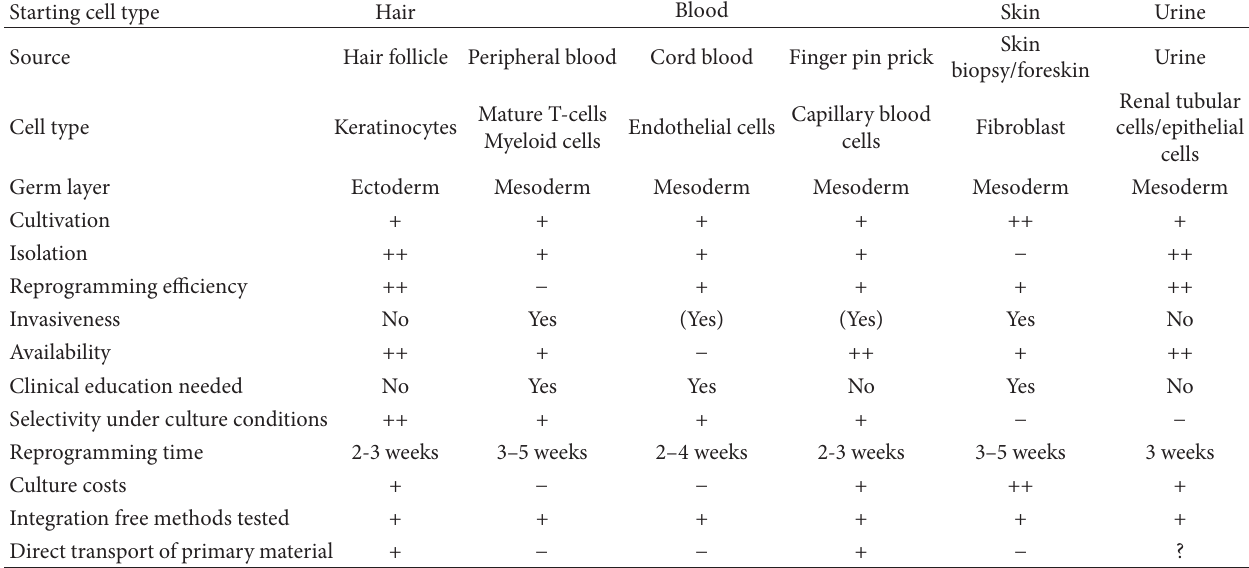
Table 1: Comparison of different starting cell